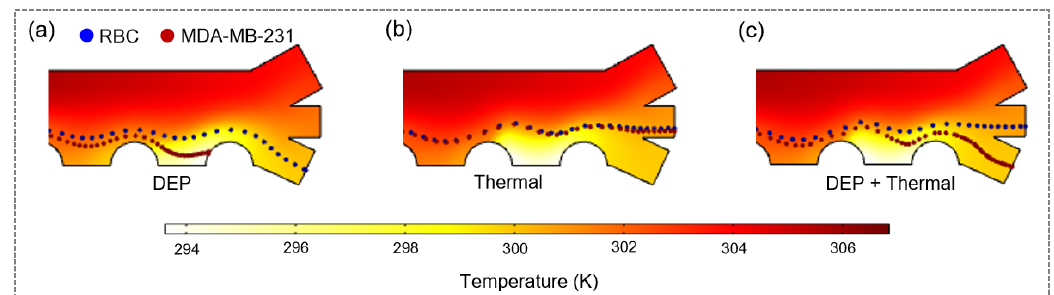
Figure A13. Distribution of heat flow in hybrid floating cIDE separator under zero initial velocity ( u 1 = 0, u 2 = 0).